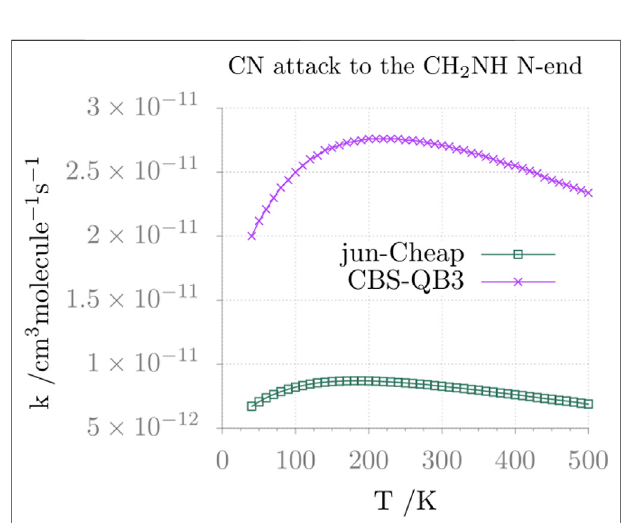
FIGURE 6 | Reaction rate constant (and its temperature dependence) for the formation of N-cyanomethanimine (N-CMIM) upon CN attack at the N-side of methanimine.